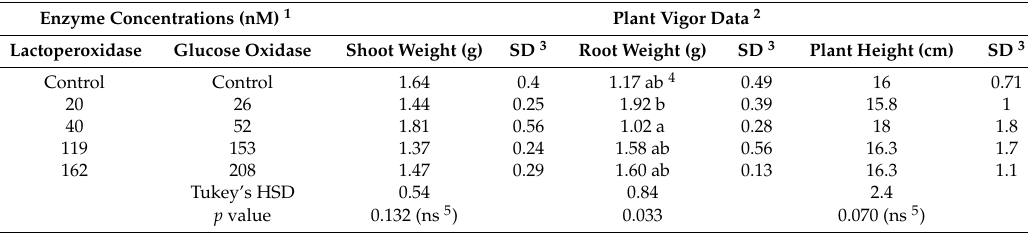
Table 2. Plant vigor data for tomato seeds coated at different enzyme